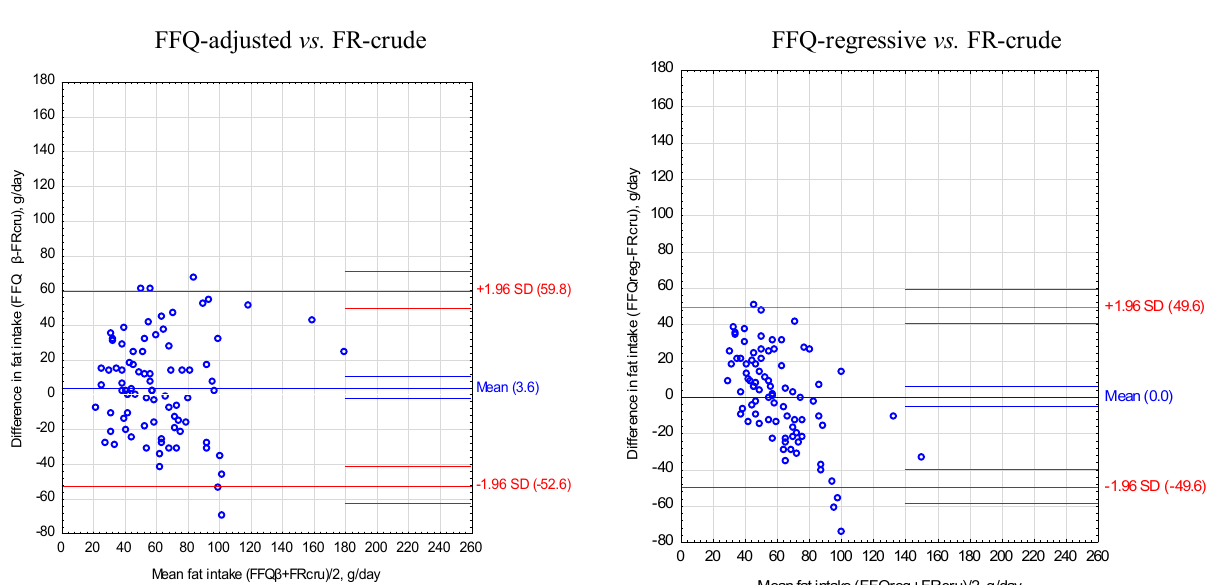
Figure 2. Cont. FFQ-adjusted vs. FR-crude FFQ-regressive vs. FR-crude